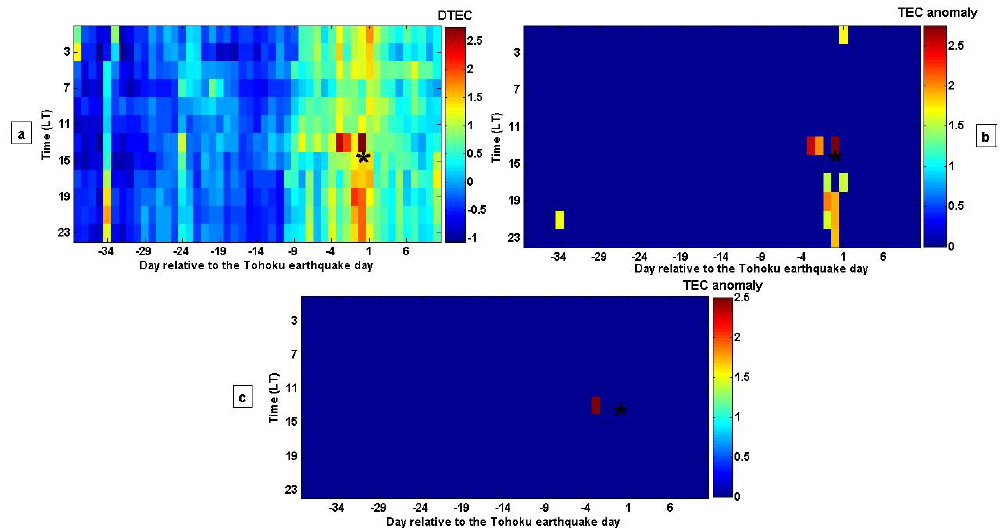
Fig. 3. Results of analysis for the Tohoku earthquake using median method, (a) DTEC variations, (b) detected TEC anomalies without considering the geomagnetic conditions and (c) detected TEC anomalies during quiet geomagnetic